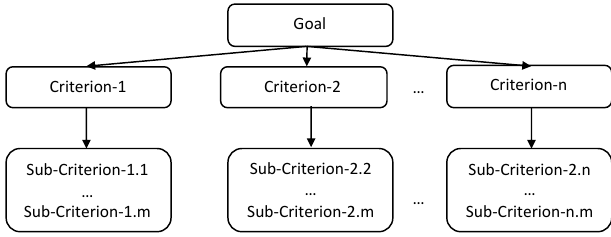
Figure 1. SF-AHP hieratical structure.